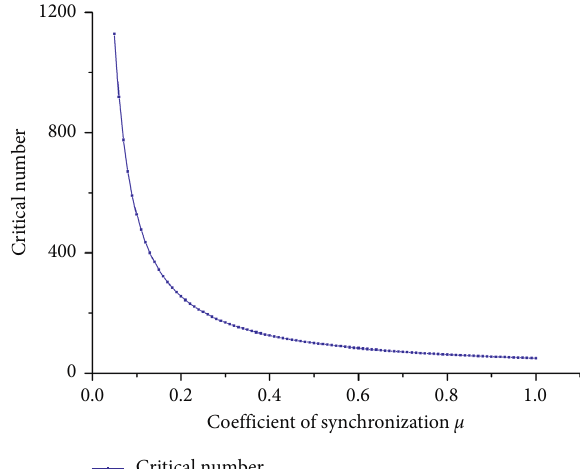
Figure 12: The relationship between critical number of pedestrians and synchronization coefficient under parametric